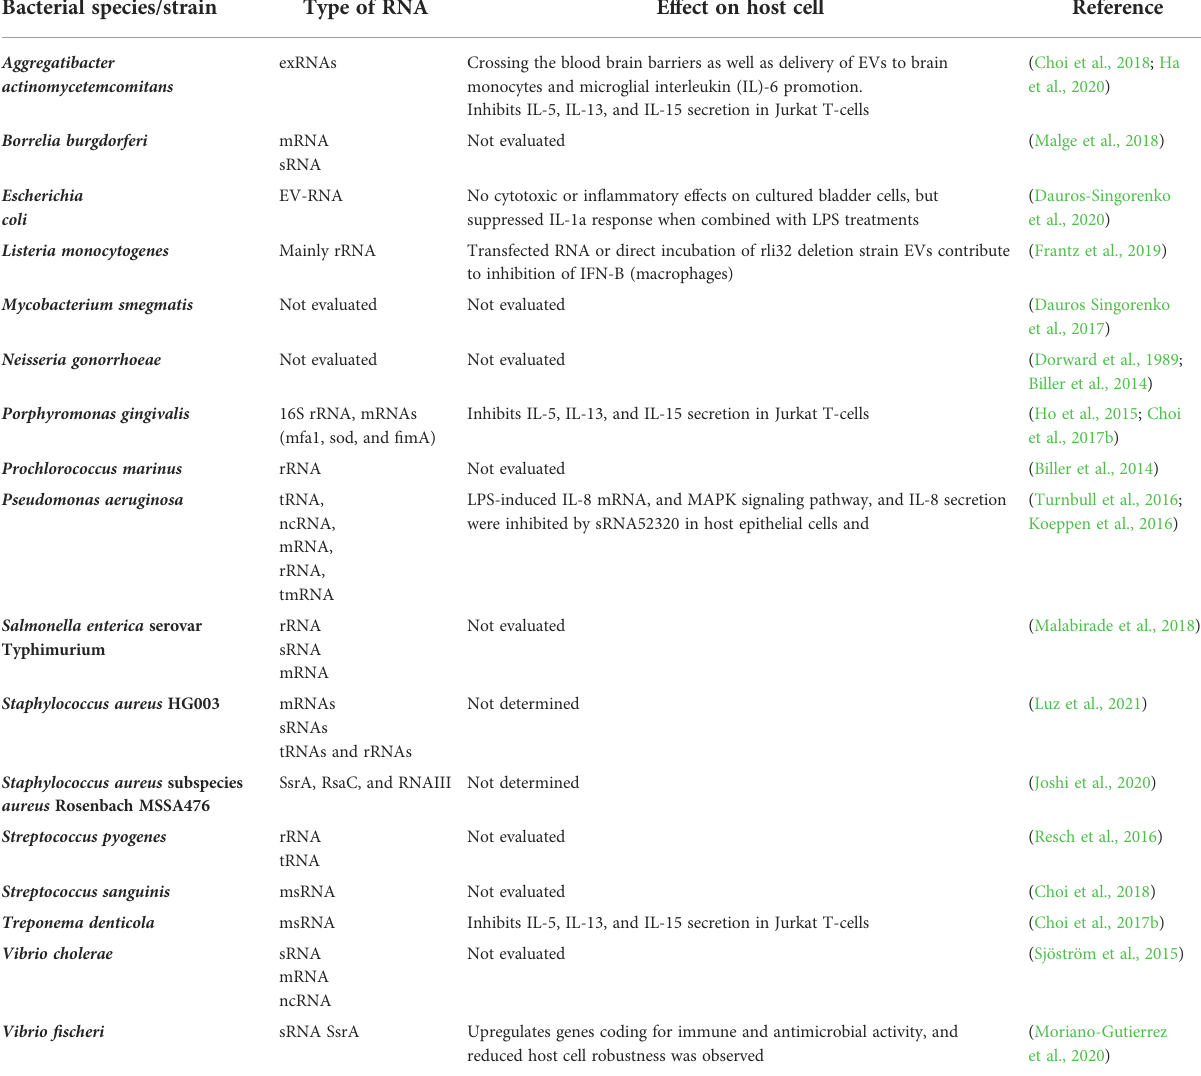
TABLE 1 Studies on different types of RNA released by bacteria and their effects on host cells. Bacterial